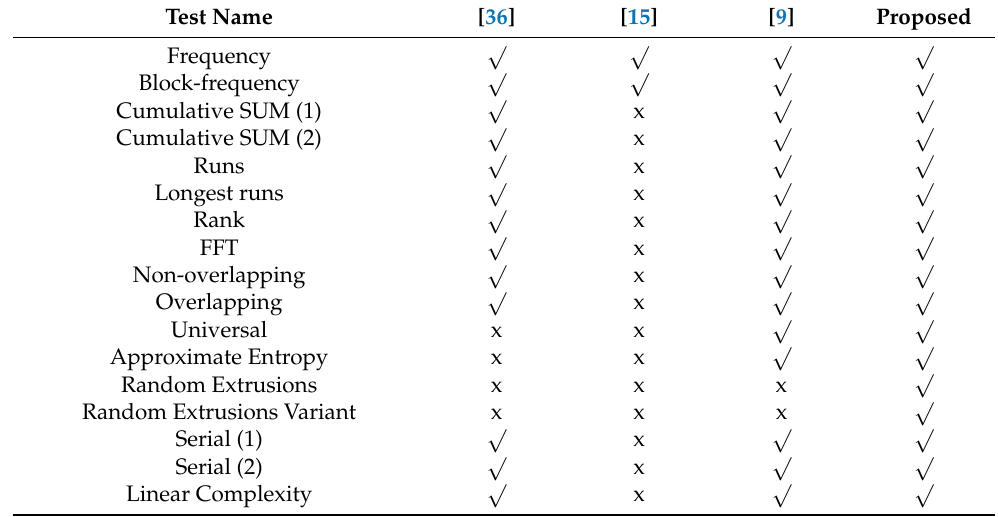
Table 7. Comparison of the proposed system with existing DNA-based systems in terms of